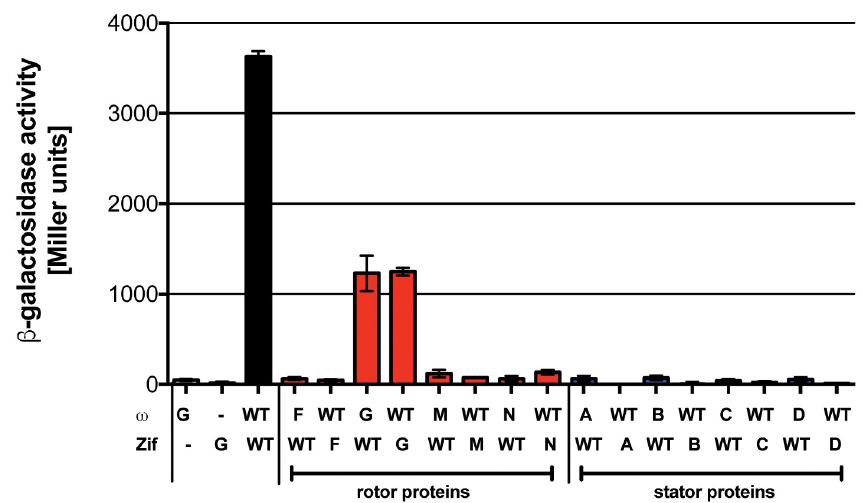
Fig 2. The C ring component FliG interacts with FlhF. FlhF interactions with flagellar proteins were assayed by bacterial two-hybrid assay. ω or Zif fusions were tested as indicated, with interactions resulting in beta-galactosidase expression and activity (reported in Miller units). Bars show mean ± S.D. (n = 3) for a representative experiment. FlhF (WT), which forms a homodimer, served as a positive control (black bar). FliG (G) interacted with wild-type FlhF (WT) (red bars), but gave no signal when co-expressed with either the ω or Zif domain alone (white bars). Other tested rotor components (red bars: FliF (F), FliM (M), or FliN (N)) and stator proteins (blue bars: MotA (A), MotB (B), MotC (C), or MotD (D)) did not show interactions with